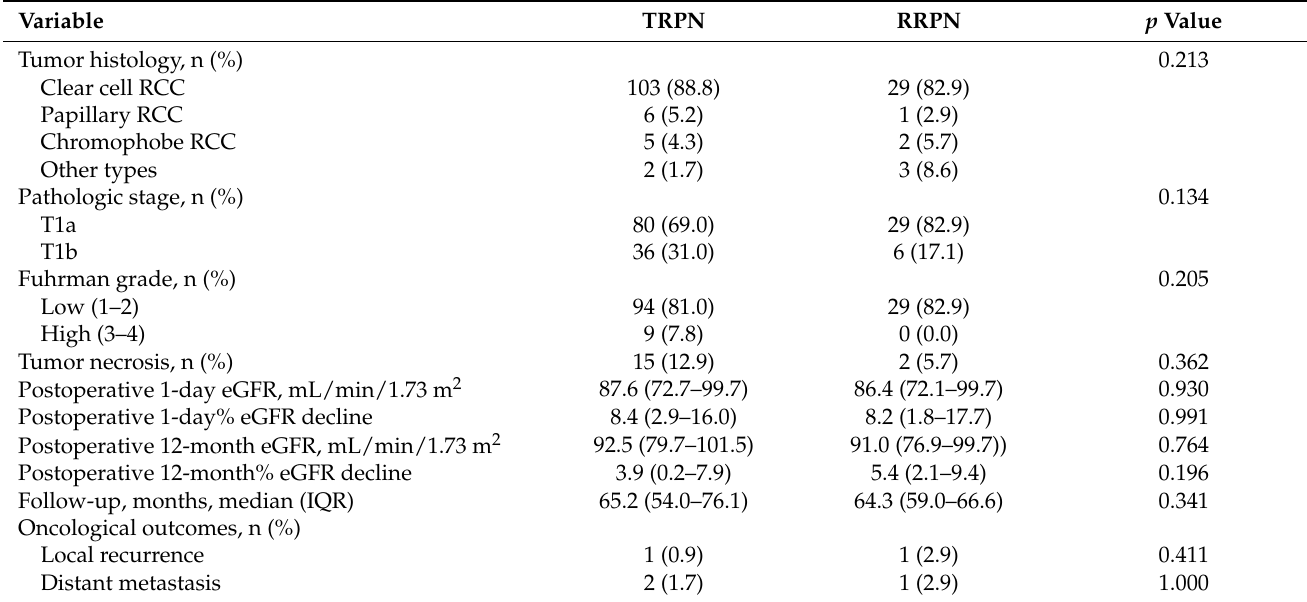
Table 3. Pathological outcomes and follow-up